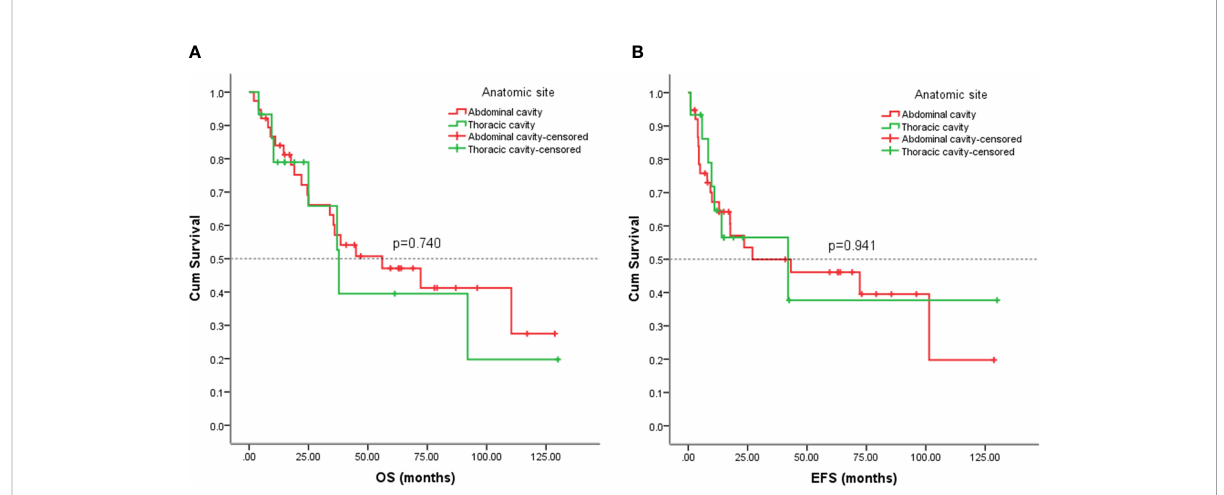
FIGURE 10 Kaplan-Meier analysis of OS and EFS for patients with visceral sarcoma in the abdominal and thoracic cavities. (A) Kaplan-Meier analysis of OS for patients with visceral sarcoma in the abdominal and thoracic cavities (p=0.740). (B) Kaplan-Meier analysis of EFS for patients with visceral sarcoma in the abdominal and thoracic cavities